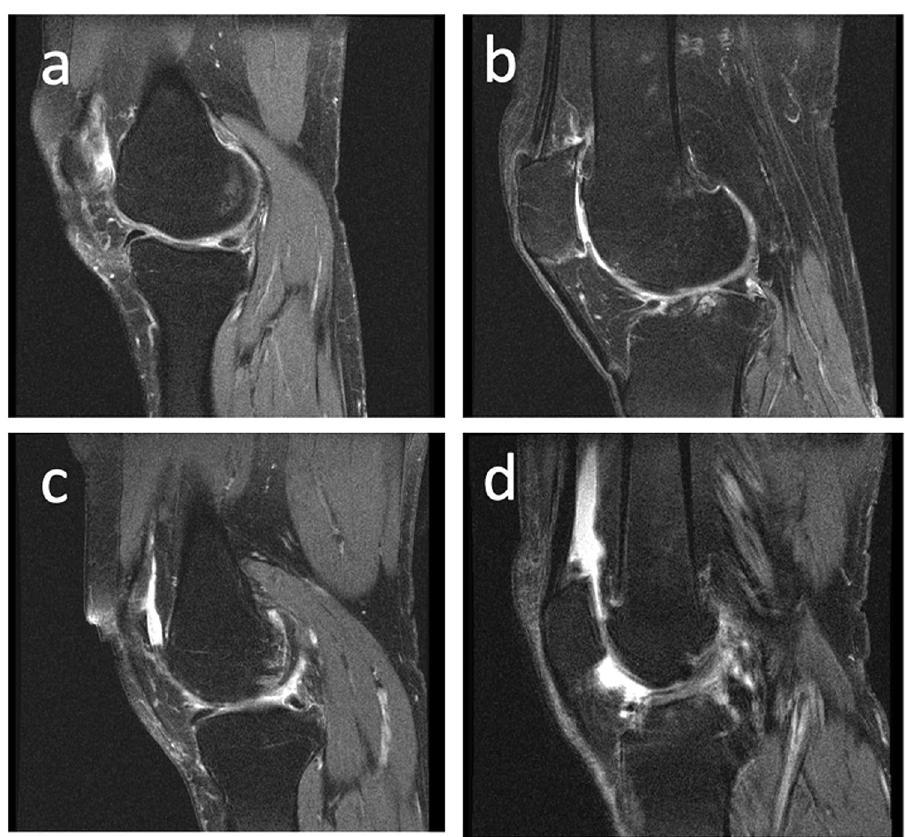
Figure 1. Examples of subjects with ( a ) Normal knee (MOAKS score 0), ( b ) Small effusion (MOAKS score 1), ( c ) Medium effusion (MOAKS score 2), and ( d ) Large (MOAKS score 3) effusion. In this work, a binary classification is used, with images as in panel ( a ) classified as without effusion, while images as in panels ( b – d ) are classified as with